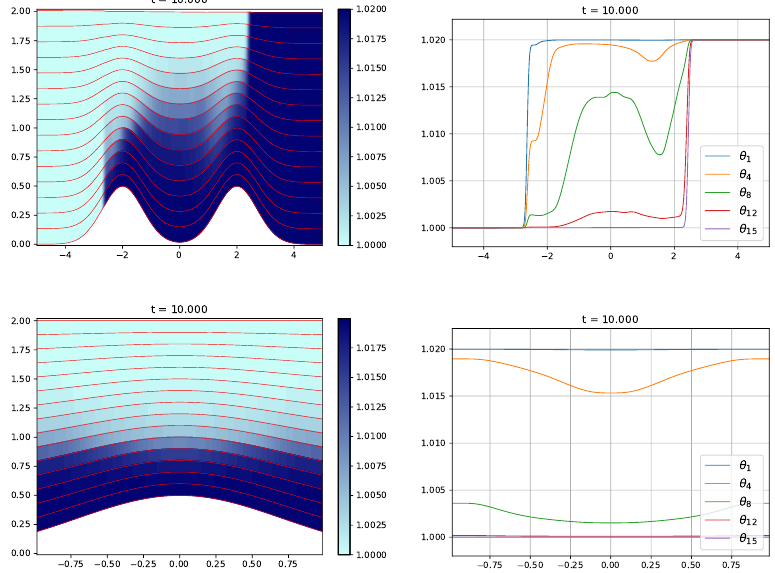
Figure 34. Initial condition for a cut in the planes y = 0 (upper row) and x = − 2 (lower row).